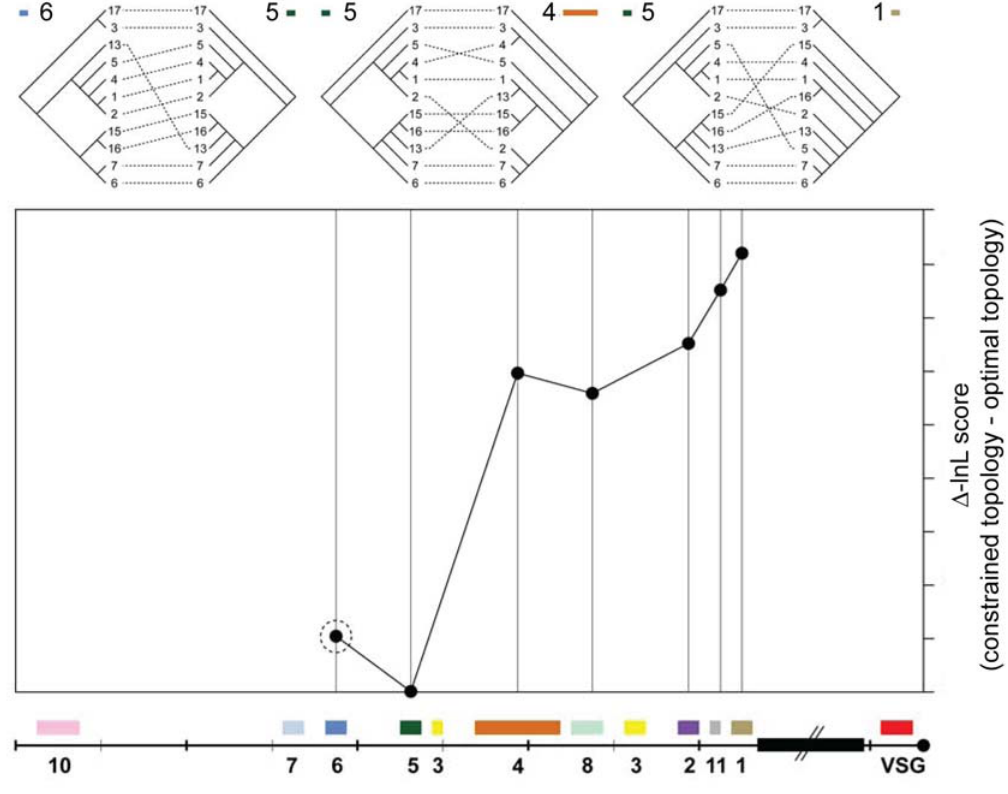
Figure 4. Quantifying the difference in phylogenetic signal along the bloodstream expression site. A. Three tanglegrams relate the ESAG5 phylogeny with those of ESAG6 (close match), ESAG4 (moderate incongruence) and ESAG1 (severe incongruence). Dashed lines link corresponding expression sites in each tree. Incongruence between trees increases from left to right. B. Comparison of likelihood scores between optimal and constrained tree topologies for ESAG5 . The phylogenies of six other ESAG loci (indicated by a cartoon of the expression site) were used to constrain the estimation of the ESAG5 tree; the difference in likelihood score between each of these constrained trees and the optimal ESAG5 tree is plotted along the expression site. Non-significant differences in likelihood are denoted by a dashed circle as evident when constraining the ESAG5 topology with the ESAG6 topology; however, enforcing the topologies of central loci ( ESAGs 4 and 8 ) caused a moderate decrease in likelihood, whilst constraining with ESAG s 2 , 11 or 1 caused a larger